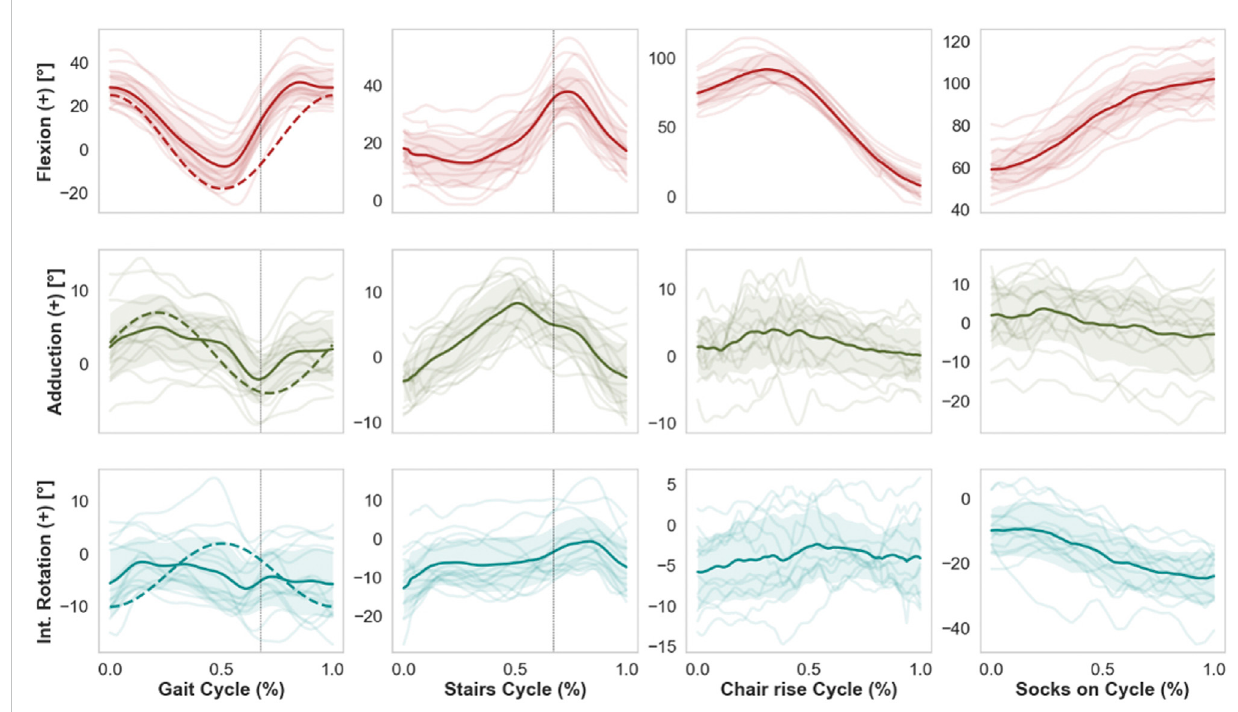
FIGURE 4 Mean kinematic curves (solid line) of 15 THA subjects during whole cycles of gait, stair descent, chair rise, and putting on socks. Shaded bands indicate standard deviations, while single semi-transparent lines refer to the individual per-subject kinematics averaged over fi ve cycles. Dashed vertical linesindicatethetimeoftoe-offforthekinematicsofgaitandstairsdescent.Dashedcurvedlinessuperimposedontheactivityofgaitrefertothecurrent ISOstandard.Ofnote,thecurrentISOstandardforweartestingfailstocapture,e.g.,theextensiverangeof fl exionobservedinspeci fi cdailyactivities such as chair rise or putting on socks, therefore these less frequent but potentially challenging activities are excluded from standard pre-clinical device